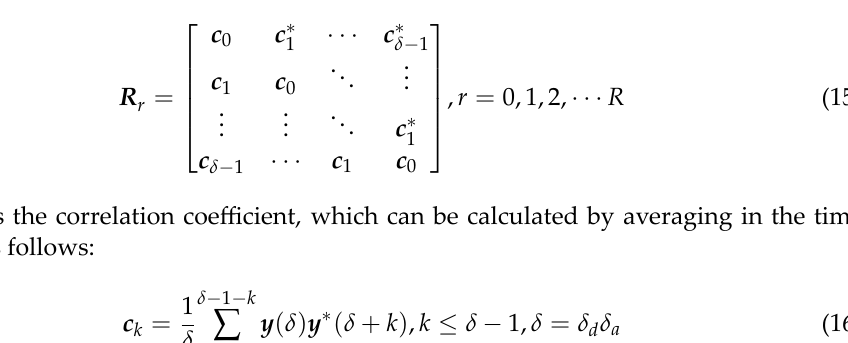
Heterogeneous samples Figure 3. The optimal training samples structure. 2.4.2. Rotating Spatial Beam Method It is assumed that the echo of the compact HFSWR is occupied by the transient inter- ference in the slow-time index 0 m and reference range unit 0 r . The training samples of the reference unit have been obtained based on Section 3.1. Let 1 2 ,